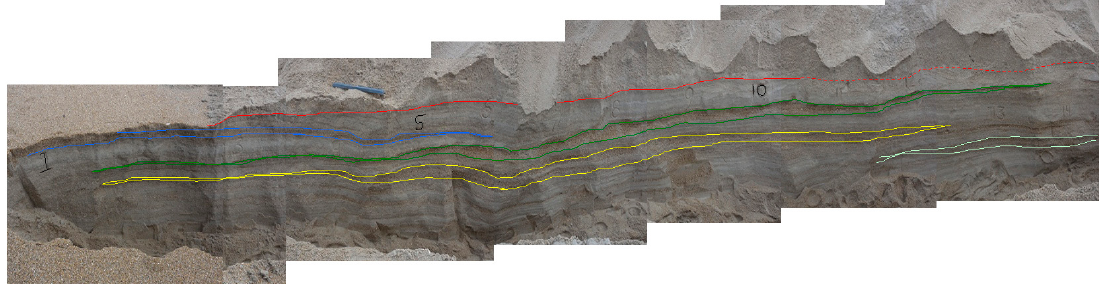
Figure 7. This image is the same as the bottom panel in Figure 6 but with specific coarse layers highlighted to illustrate their size, shape, and extent.